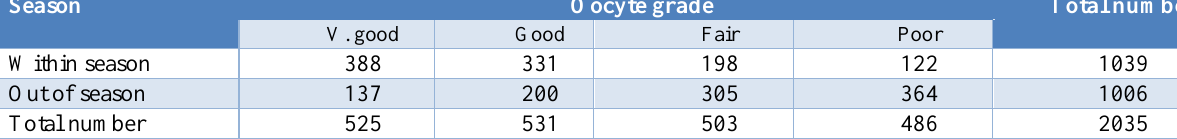
Table, 5: Oocytes account and quality grading within and out of season.